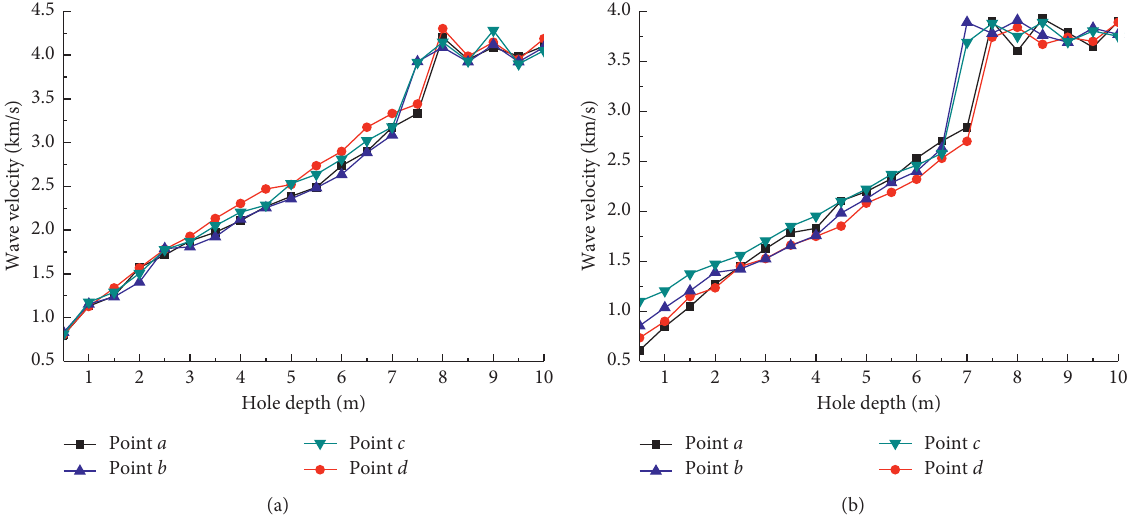
Figure 7: Hole depth-wave velocity curve of sections. (a) DK234 +205 section. (b) DK234 +318